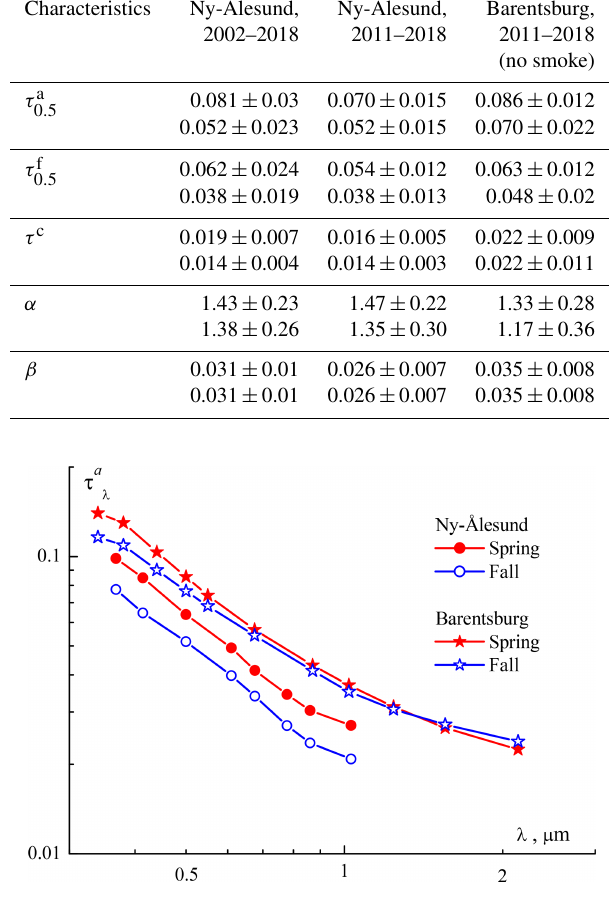
monthly τ c values are about 0.015 in Ny-Ålesund and 0.022 in